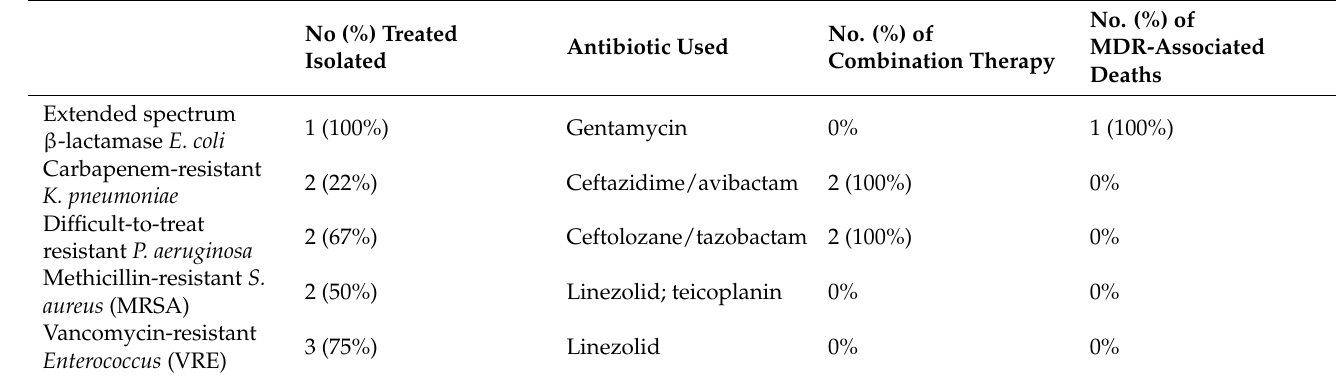
Table 3. Treatment options for MDROs during the first phase of the pandemic at the IRCCS Humanitas Research Hospital.